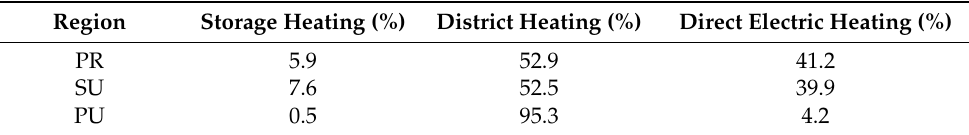
Table 2. Loading (heating) distributions for three types of investigated